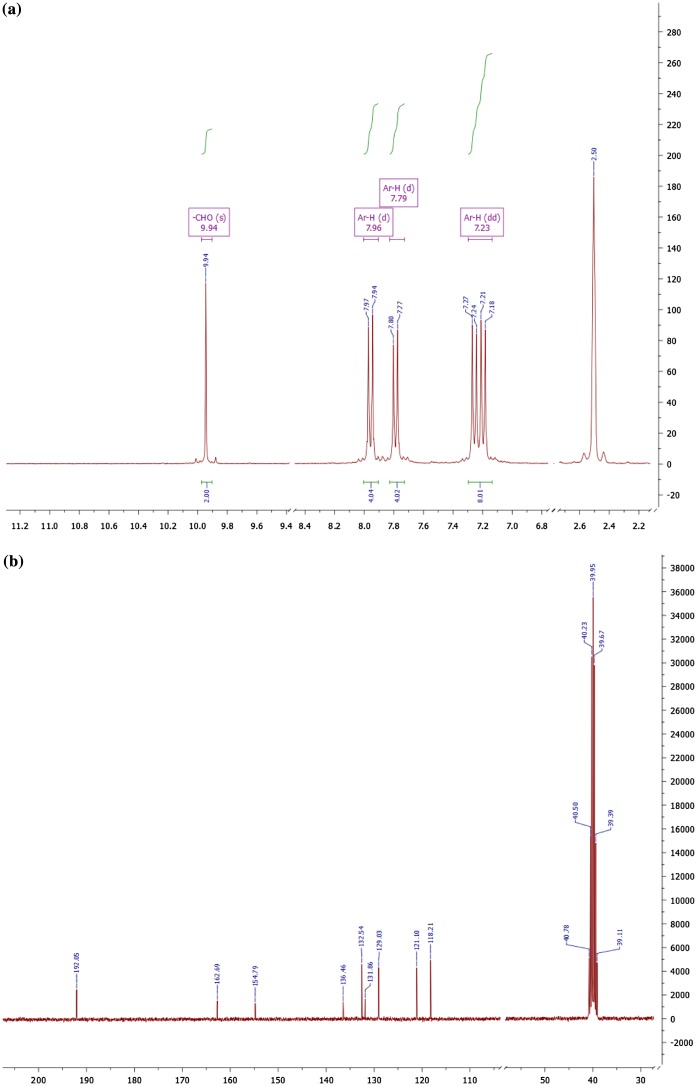
(a) Proton and (b) carbon NMR of monomer 3d in DMSO-d6
.